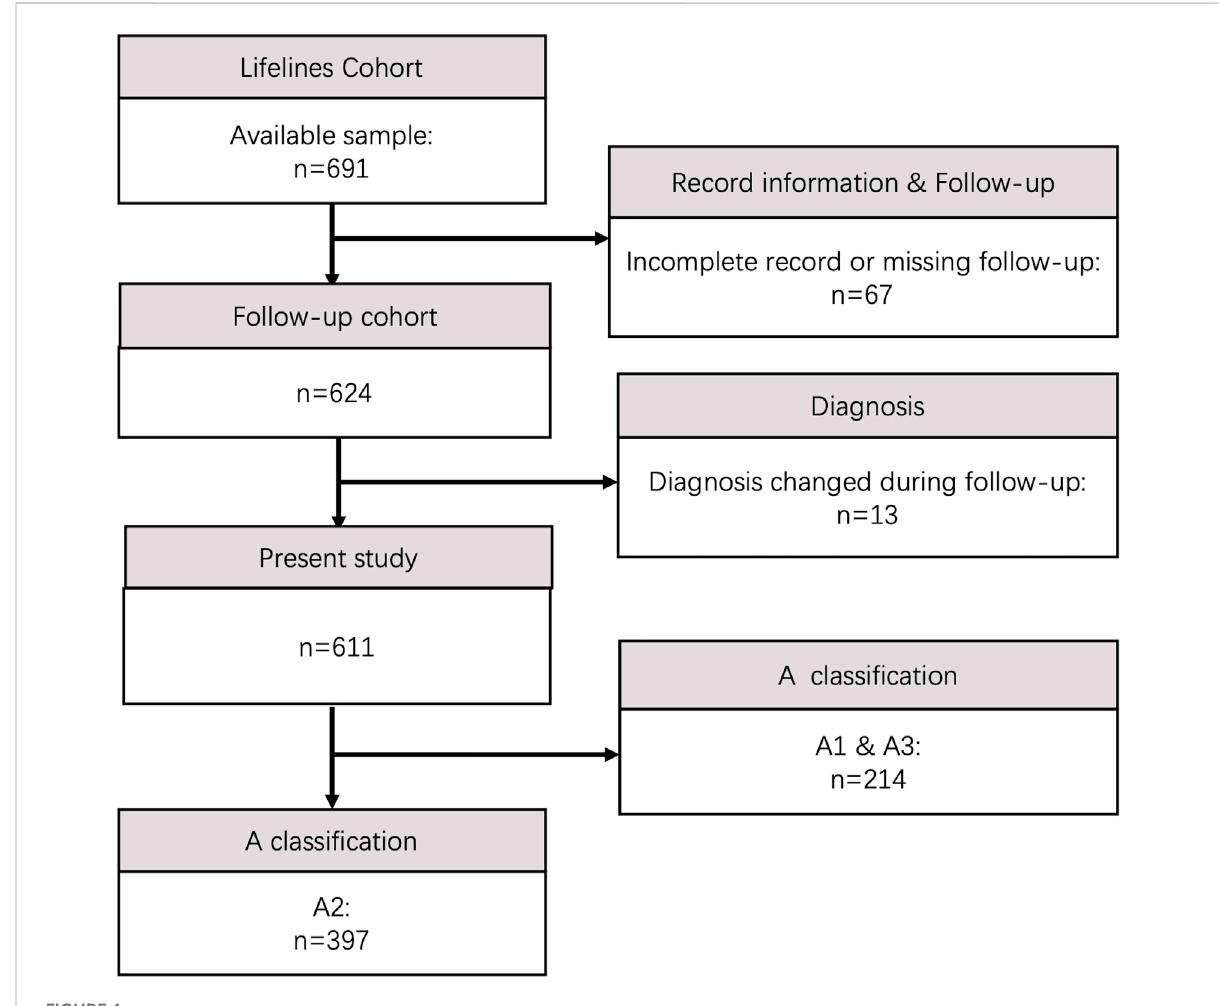
FIGURE 1 Flowchart of lifelines participant